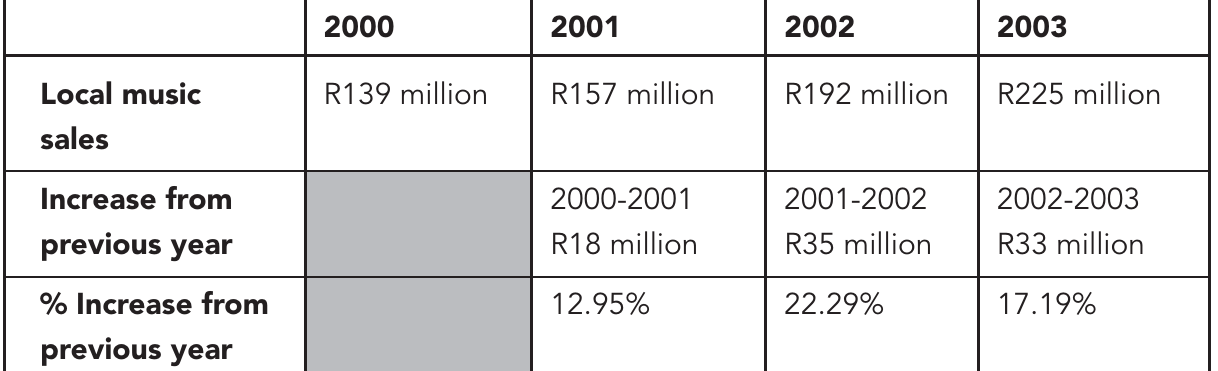
Table 2: Increases in local music